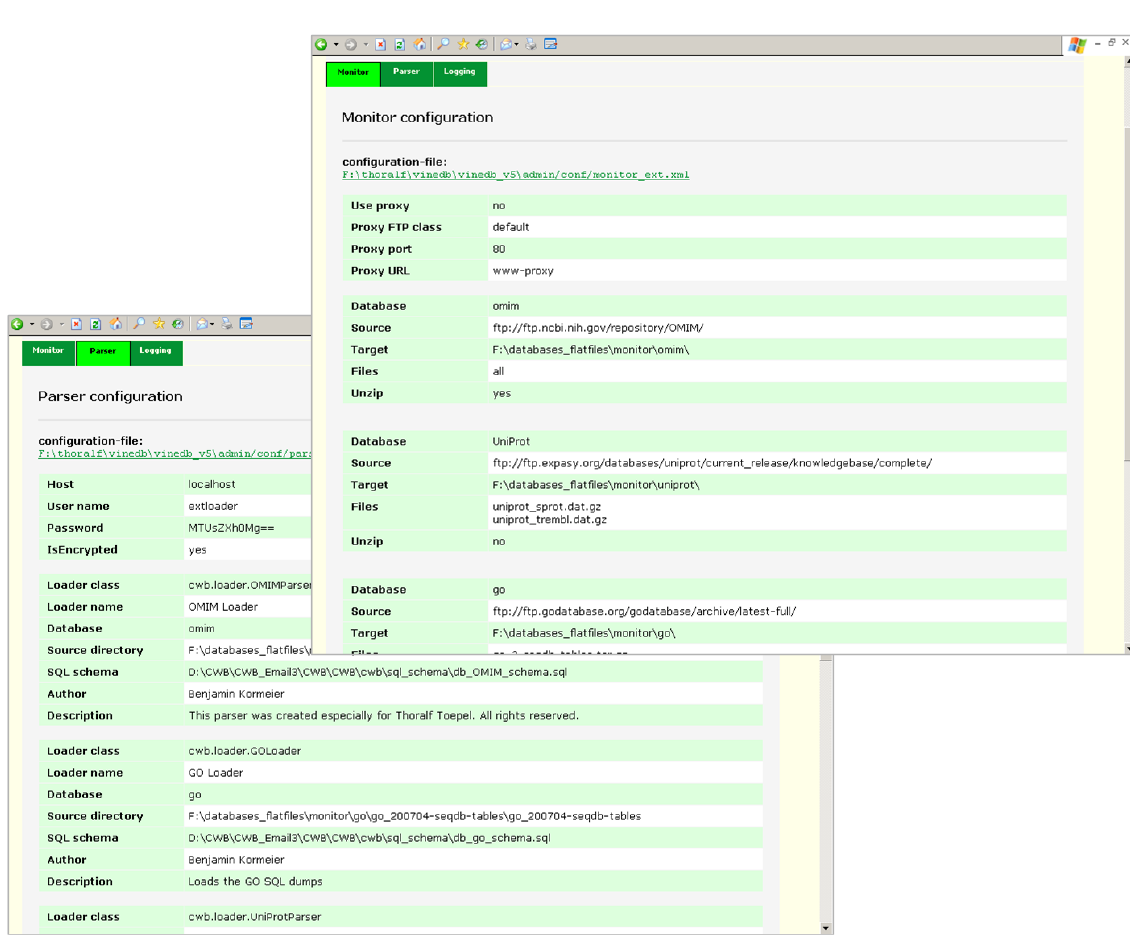
Figure 2: Screenshot of the web-based administration tool with XML configuration files. a) The monitor configuration mainly consists of parameters that specify the proxy server and the ob- served data sources identified by ftp directories and relevant files. b) A parser configuration con- tains the connection parameters for the local database management system and details of the parser that extract and store the data in the